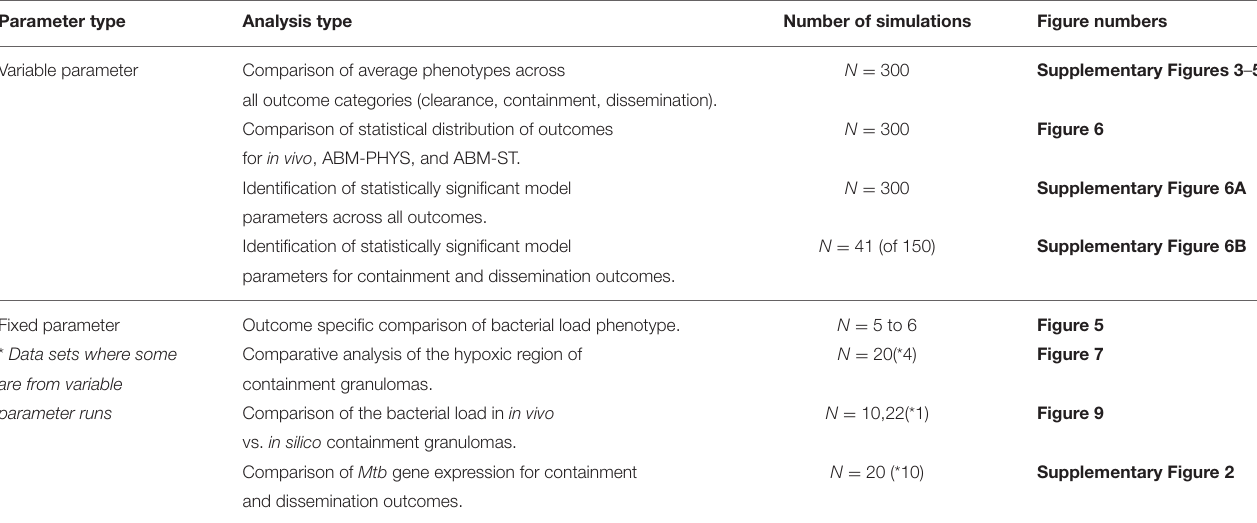
TABLE 7 | Explanation of simulation data sets used to generate figures of aggregate results and comparative outcome for ABM-PHYS and